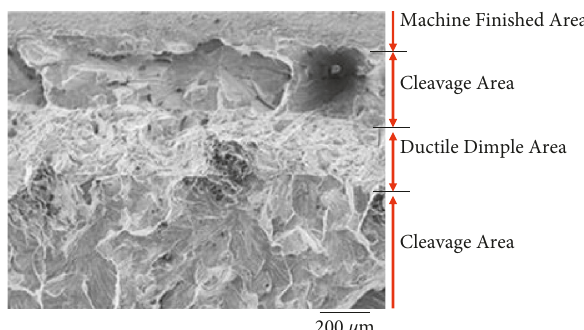
Figure 3: SEM micrograph exhibiting dimple and cleavage rupture mechanisms at a fracture zone [14].